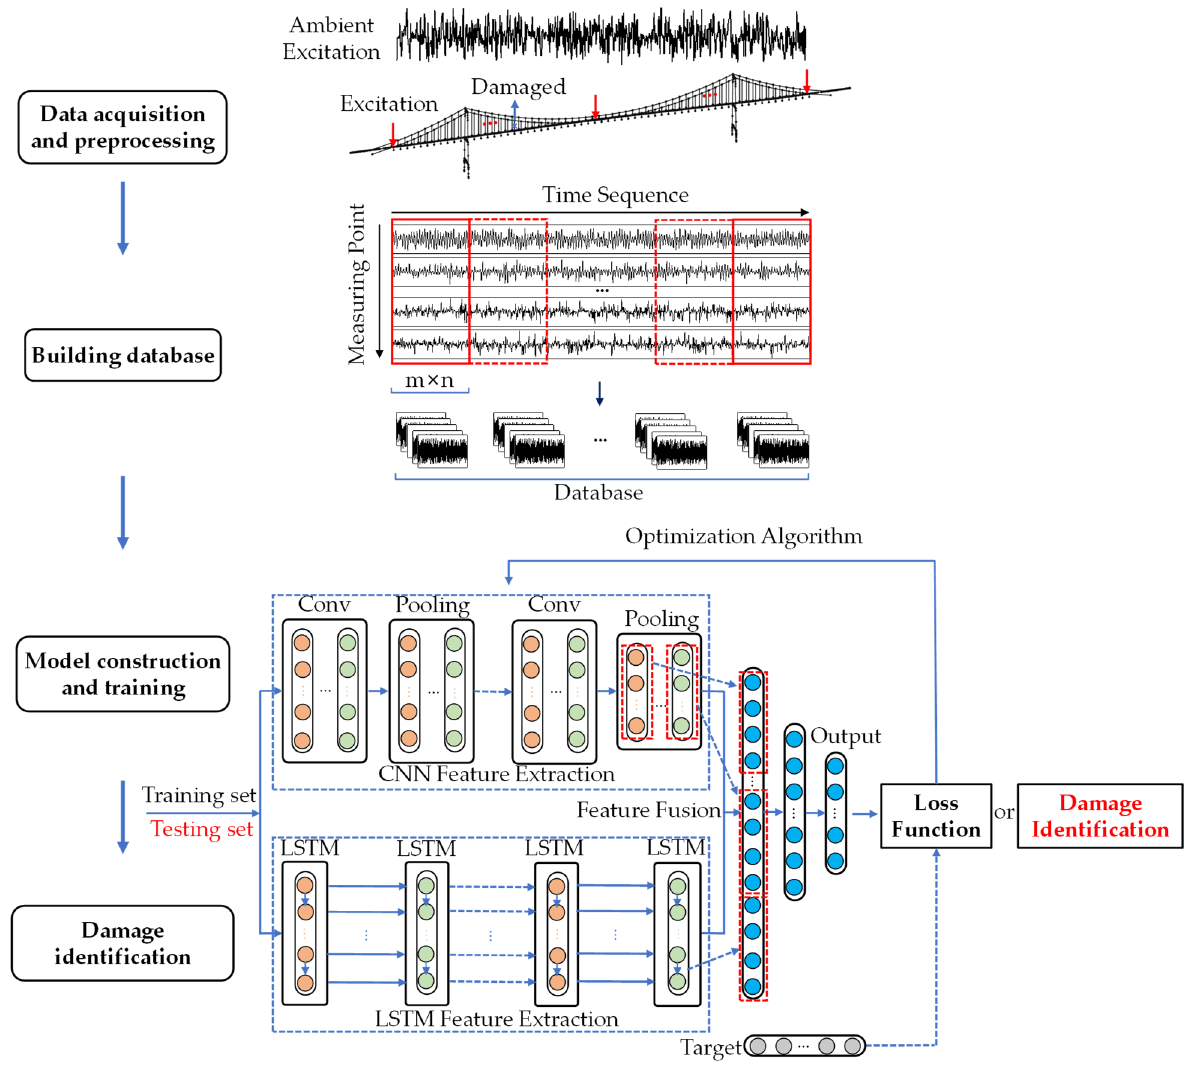
Figure 4. Flowchart of CNN-LSTM model-based damage identification method.